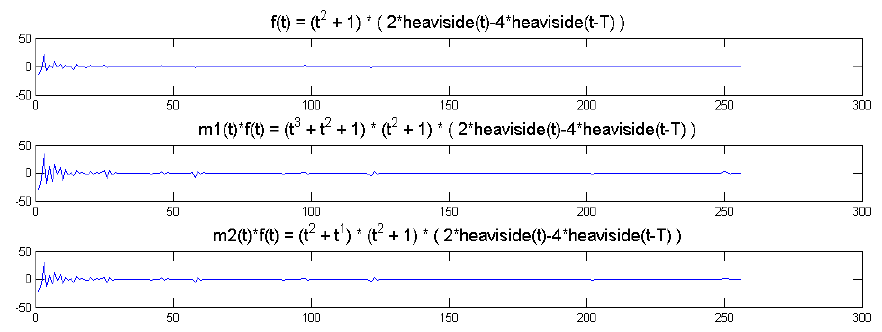
Figure 7. Wavelet transform of original and modulated signals. ( Top ) to ( bottom